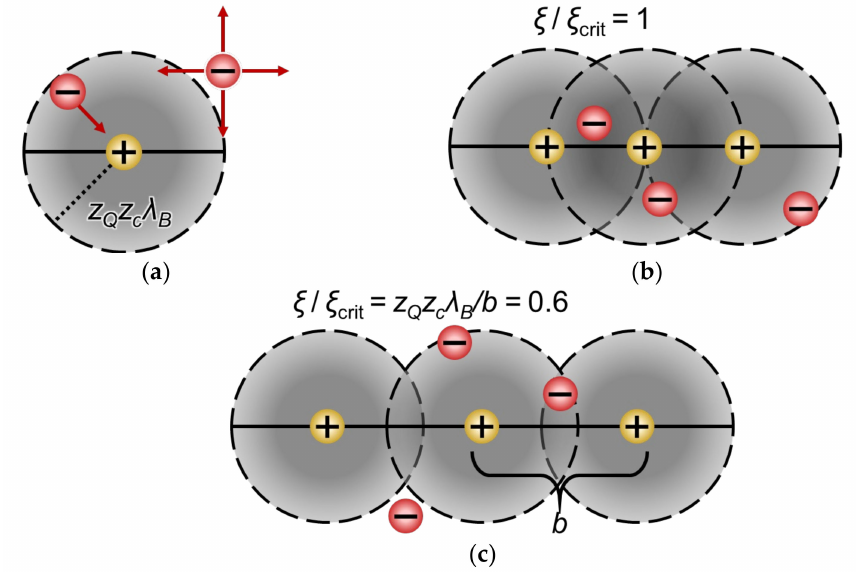
Figure 9. Schematic representation of the attraction of counterions by neighboring functional groups of a polyelectrolyte chain at different ξ / ξ crit . ( a ): Within a distance of z Q z c λ B the counterions escape the attractive force of a fixed ion to diffuse away. ( b ): Region of adjacent electrostatic influence overlaps at the location of the fixed charges. ( c ): Region of adjacent electrostatic influence overlaps away from the fixed charge groups. Adapted from